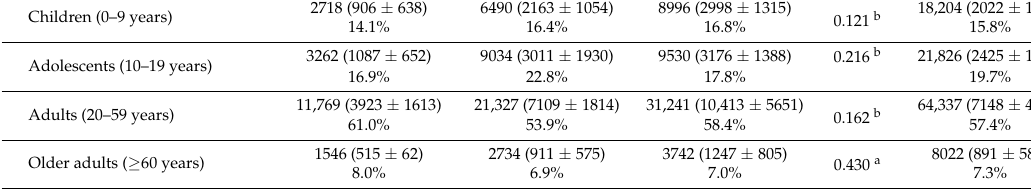
Parks Implementing Control Parks ( n = 3) p All Parks ( n = Future Recreov í as ( n = 3)